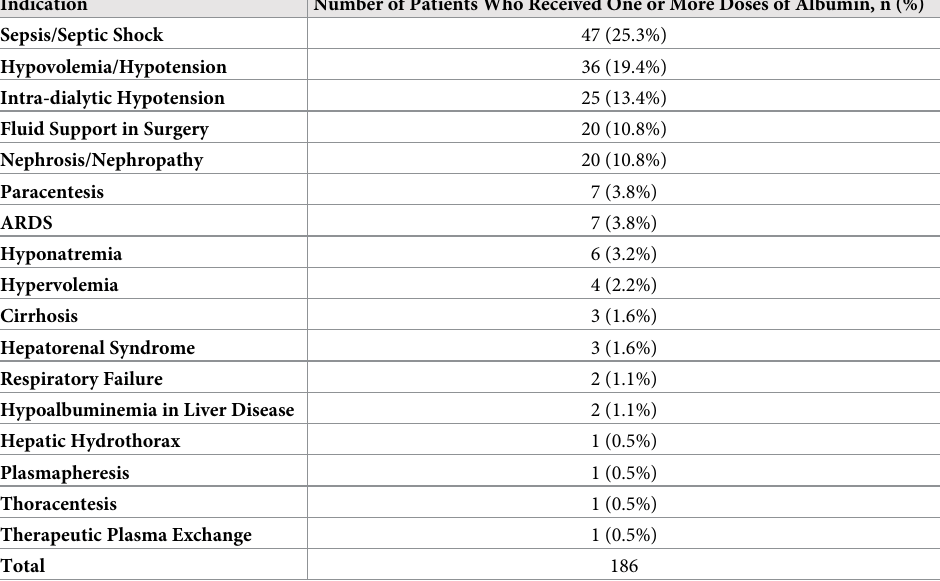
Table 2. Albumin use by